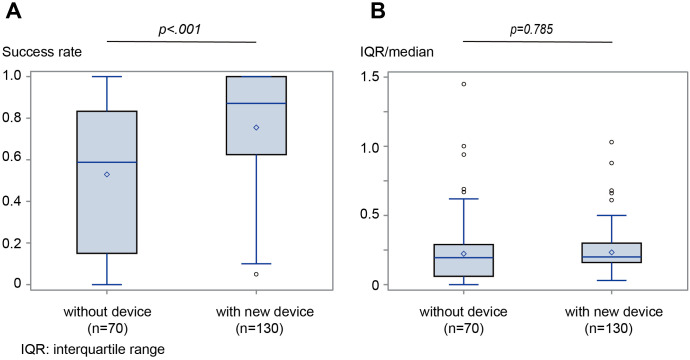
Median success rate and IQR/median of SSM with and without the new device.A) Median success rate of the SSM with the new device was higher than that of the SSM without one. B) No significant difference is observed between SSM with and without the new device. IQR = interquartile range, SSM = spleen stiffness measurement.